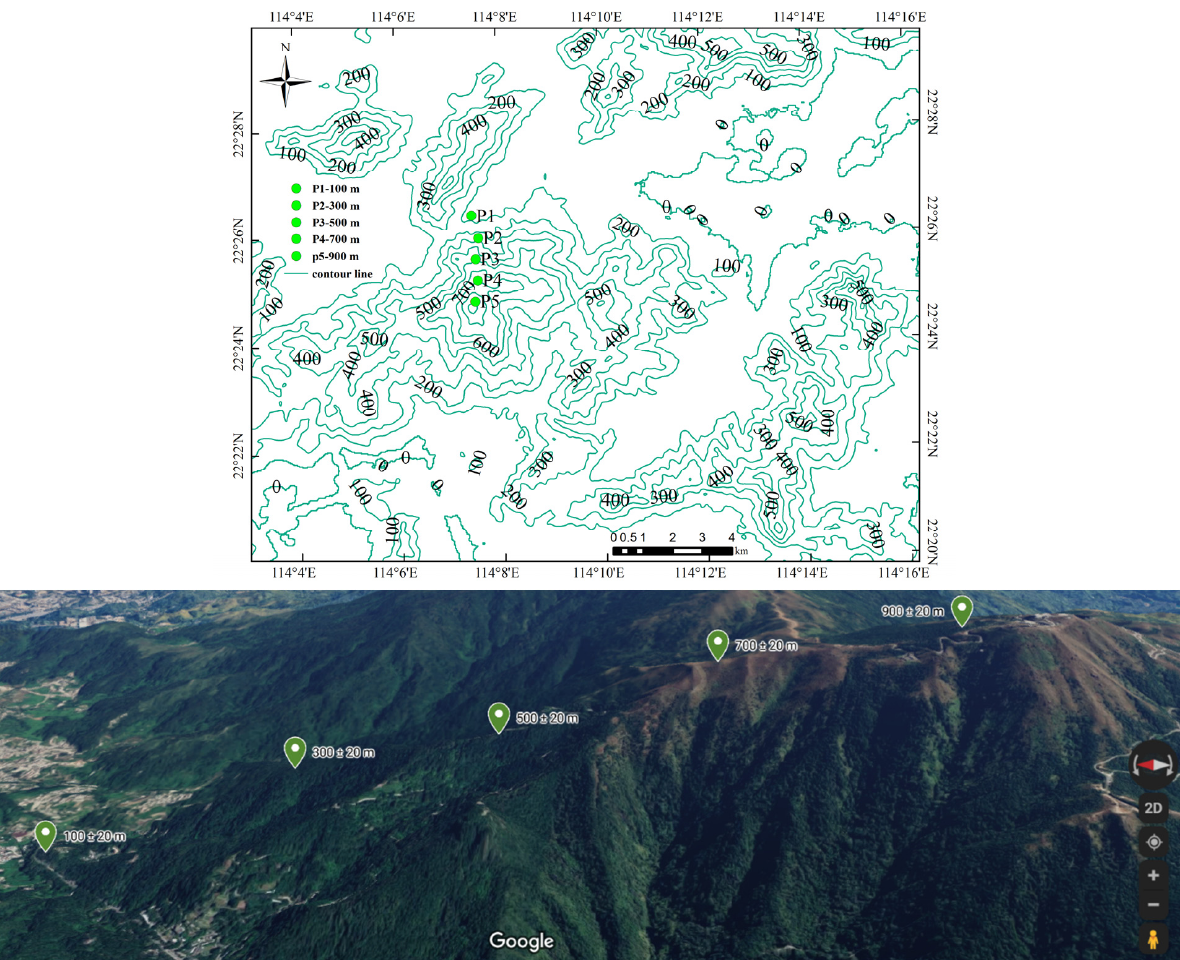
Figure 1. Map showing the study site on Tai Mo Shan in the central part of Hong Kong ( upper ), and Google map with the five sampling points on Tai Mo Shan from 100 m to 900 m with elevation intervals of 200 m ( lower ).